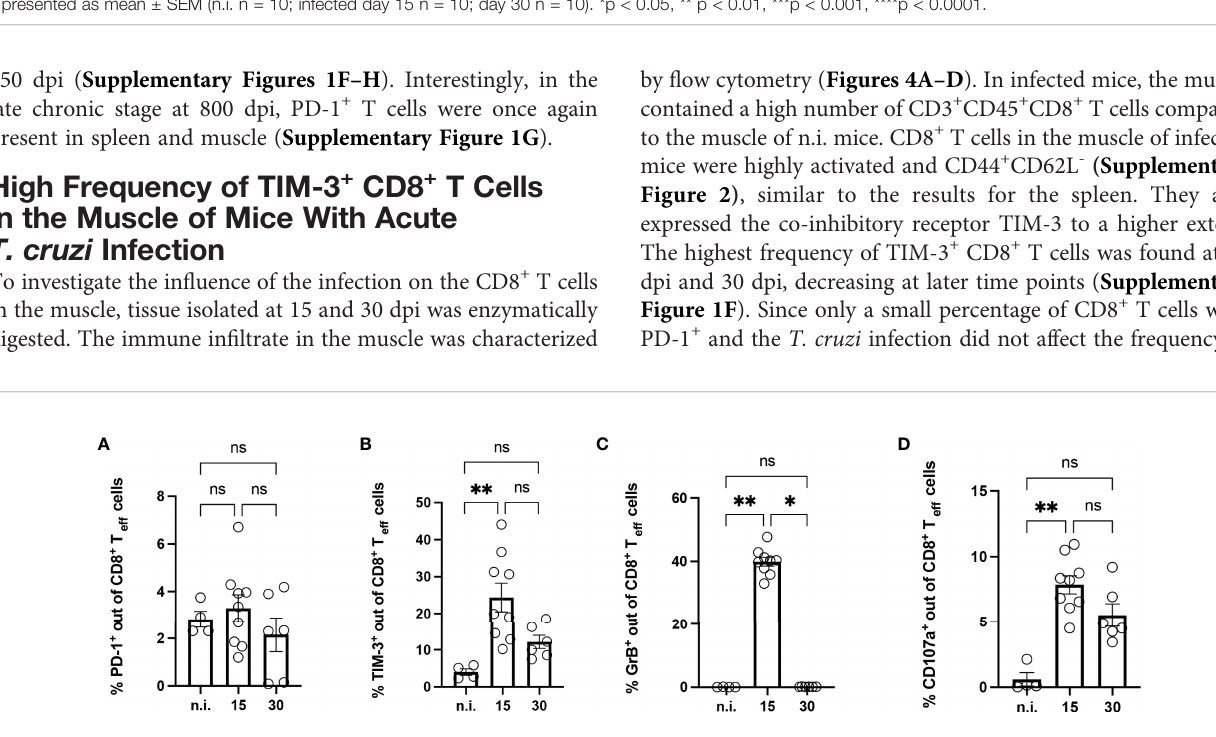
FIGURE 4 | Analysis of CD8 + T cells isolated from the muscle of mice with acute T. cruzi infection. Phenotypical analysis of CD8 + T cells isolated from muscle tissue was performed at 15 and 30 dpi using fl ow cytometry. Results are presented as percentages of effector CD8 + T cells (A) for PD-1, (B) for TIM-3, (C) for GrB, and (D) for CD107a. GrB and CD107a were stained ex vivo without previous stimulation. GrB was stained intracellularly. Results are presented as mean ± SEM. Data from three independent experiments were analyzed using the Kruskal-Wallis test and Dunn ı ́ s multiple comparison tests (n.i. n=4, day 15 n=9, and day 30 n=6). *p < 0.05, **p < 0.01, n.s. not signi fi